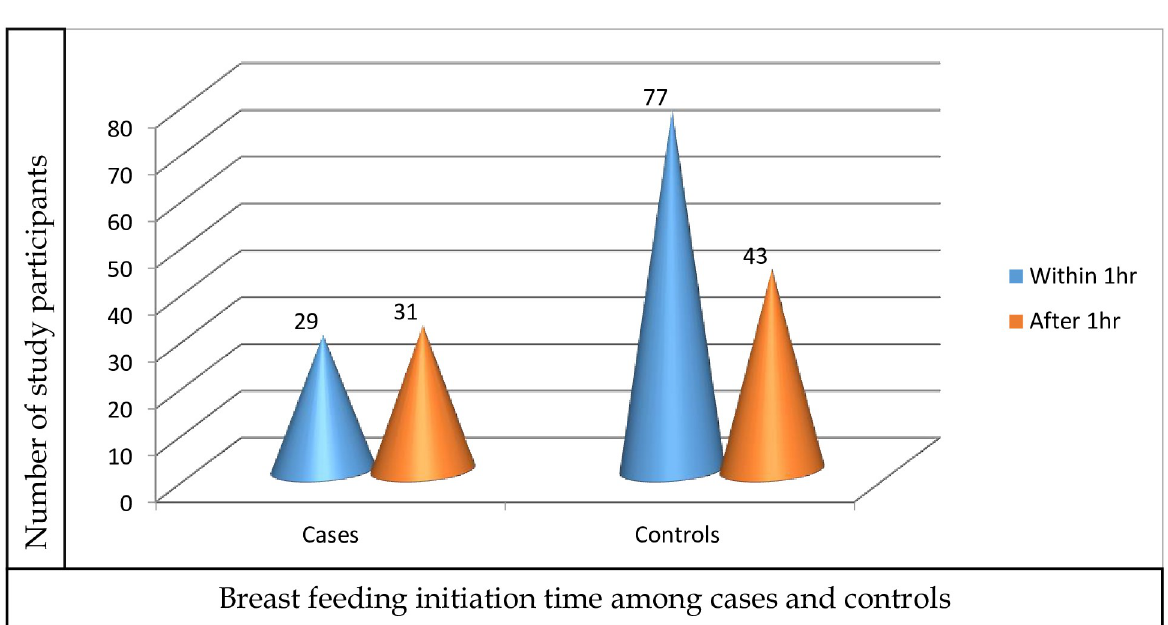
Multivariable logistic regression was done by taking the variables which were statistically significant in bivariate logistic regression (p-value of < 0.2) into account simultaneously. Then conditional back-ward elimination regression method was used after checking multi co- linearity. cant association with late-onset neonatal sepsis at p-value less than 0.05 level of significance.